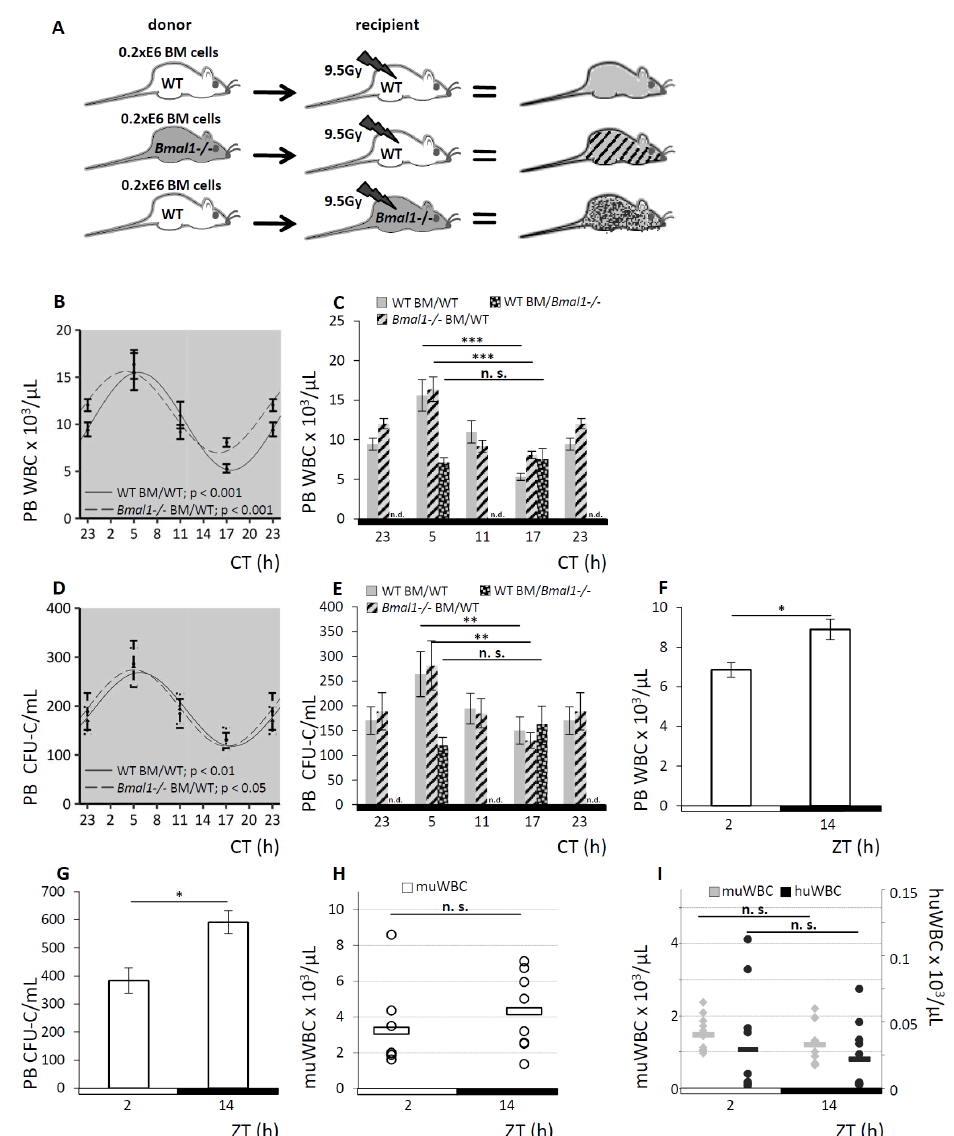
Figure 4. Hematopoietic-extrinsic cues dictate the rhythmical circadian fluctuation of hematopoietic cells . A. Scheme of the experimental set-up: radiation chimeras were generated by transplanting WT BM cells to WT hosts (grey, n = 12 per time point), Bmal1 − / − BM to WT hosts (hatched, n = 12 per time point) or WT BM to Bmal1 − / − hosts (spotted black, n = 12 per time point). After reconstitution, mice were held under DD conditions and PB WBC and CFU-C content was determined over time. B. Cosinor analysis was performed for PB WBC of WT host reconstituted with WT BM (solid line) or Bmal1 − / − BM (dashed line), see Table 1 for circadian rhythm characteristics. C. PB WBC counts shown as bar graphs, grey bars indicate WT mice reconstituted with WT hematopoiesis, hatched bars represent WT mice reconstituted with Bmal1 − / − BM, and spotted black bars depict Bmal1 − / − recipients reconstituted with WT BM. D. Cosinor analysis was performed for PB CFU-C of WT host reconstituted with WT BM (solid line) or Bmal1 − / − BM (dashed line), rhythm parameters are listed in Table 1. E. PB CFU-C counts shown as bar graphs, grey bars indicate WT mice reconstituted with WT hematopoiesis, hatched bars represent WT mice reconstituted with Bmal1 − / − BM and spotted black bars depict Bmal1 − / − recipients reconstituted with WT BM. F, G. PB from human volunteers ( n = 6) was analyzed at ZT2 or ZT14 for PB WBC ( F ) and CFU-C content ( G ). H. NSG mice were analyzed for PB WBC counts at ZT2 and ZT14 ( n = 8 mice per time point). I. In humanized NSG mice, human (black dots) and murine WBC counts (grey dots) were enumerated at ZT2 and ZT14, 10–12 weeks after transplantation ( n = 12 mice per time point, each dot represents a single measurement in one mouse). Asterisks: * p < 0.05, ** p < 0.01, *** p <